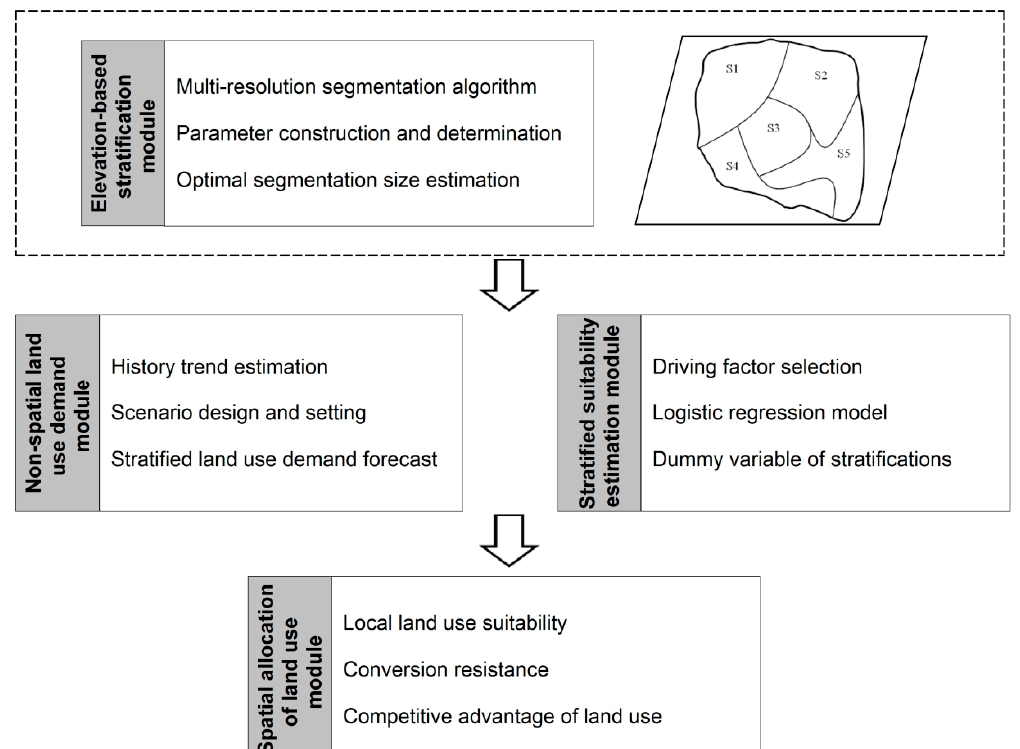
Figure 2. Overall structure of the elevation-based stratification strategy (SLUCS) model.